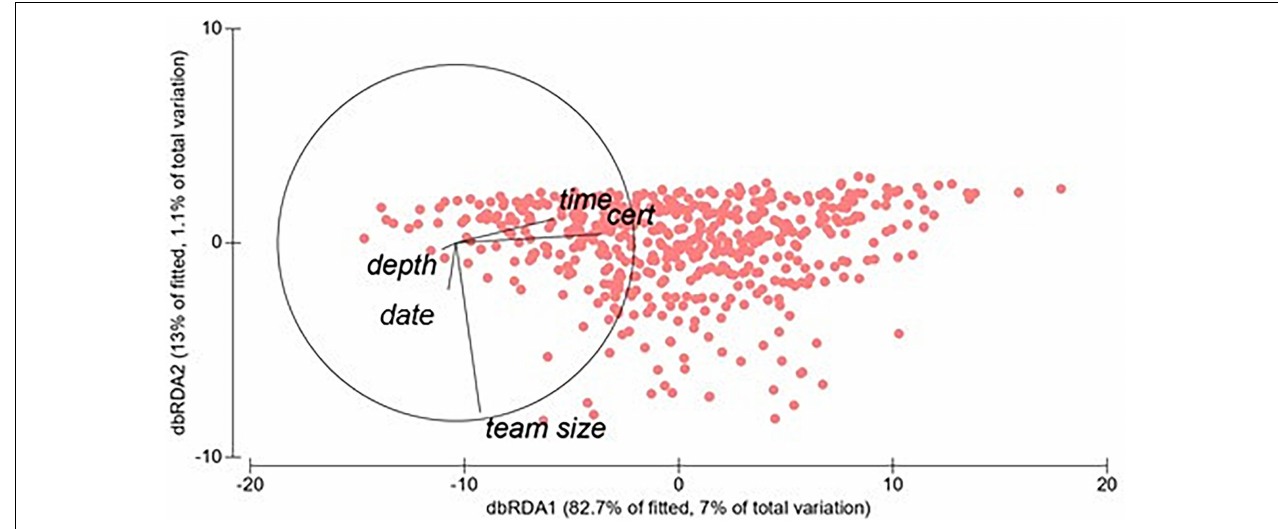
FIGURE 6 | Results of distance-based linear modeling analysis. Variables in the graphs: depth of the scuba diving activity), date of the validation trial, time is the amount of minutes spent underwater, cert is the diving certification level of volunteers and team size is the number of divers present in each validation